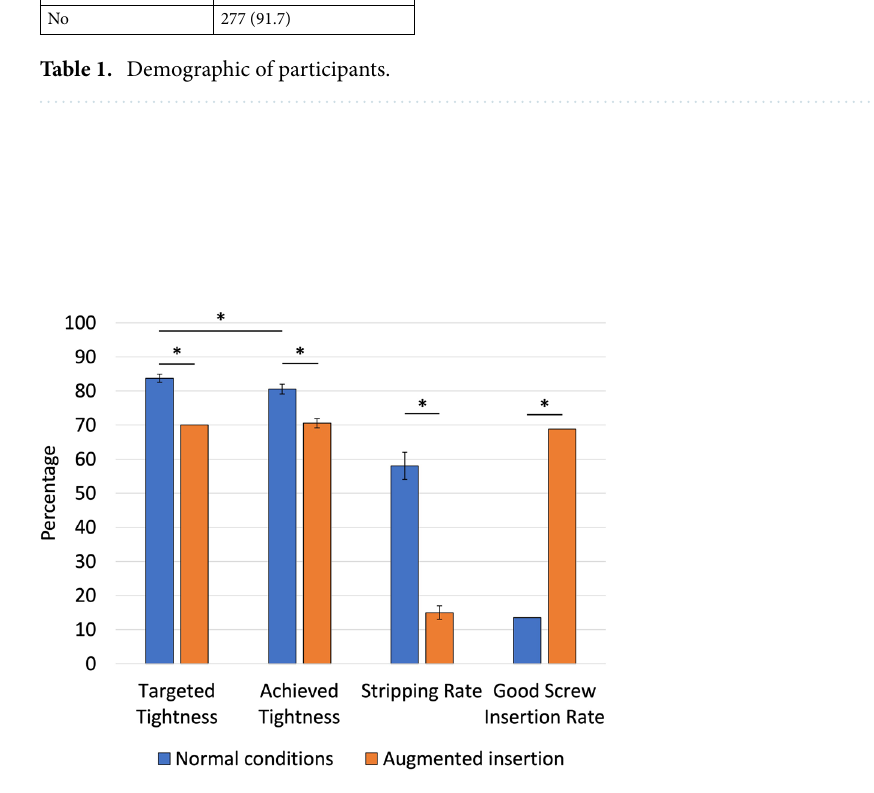
Figure 3. Surgeon performance for each of the testing conditions; normal screwdriver (blue bars) and augmented screwdriver (orange bars). Targeted tightness for normal insertion based on mean average reported by surgeons prior to insertion, and set to 70% when using the augmented screwdriver. Good performance defined as a screw stripping rate of ≤ 10% (i.e. no more than 1 of the 10 insertions were stripped) and an accuracy in correctly describing whether a screw hole was stripped or unstripped of ≥ 80% (i.e. at least 8 out of 10 answers about screw hole stripping were correct). Poor performance was defined as a failure to achieve one or both factors. Statistical differences ( p < 0.001) highlighted with